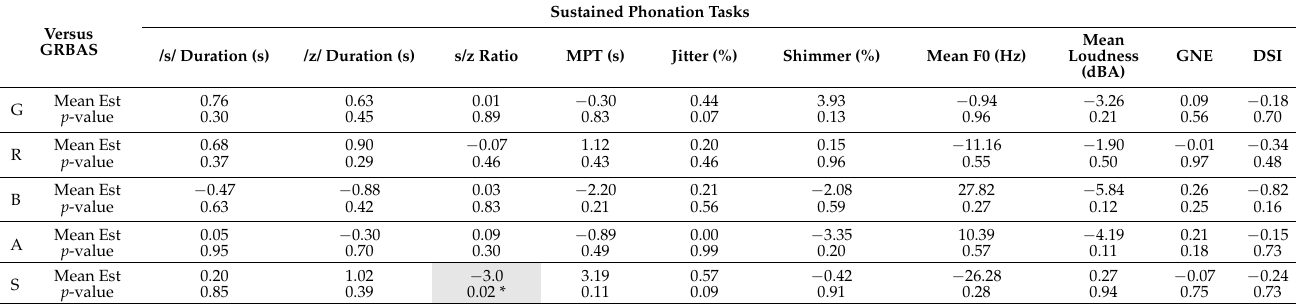
Table 5. Relationship between physiologic/acoustic voice data from sustained phonation tasks and consensus ratings from GRBAS scale, controlled for age at assessment and